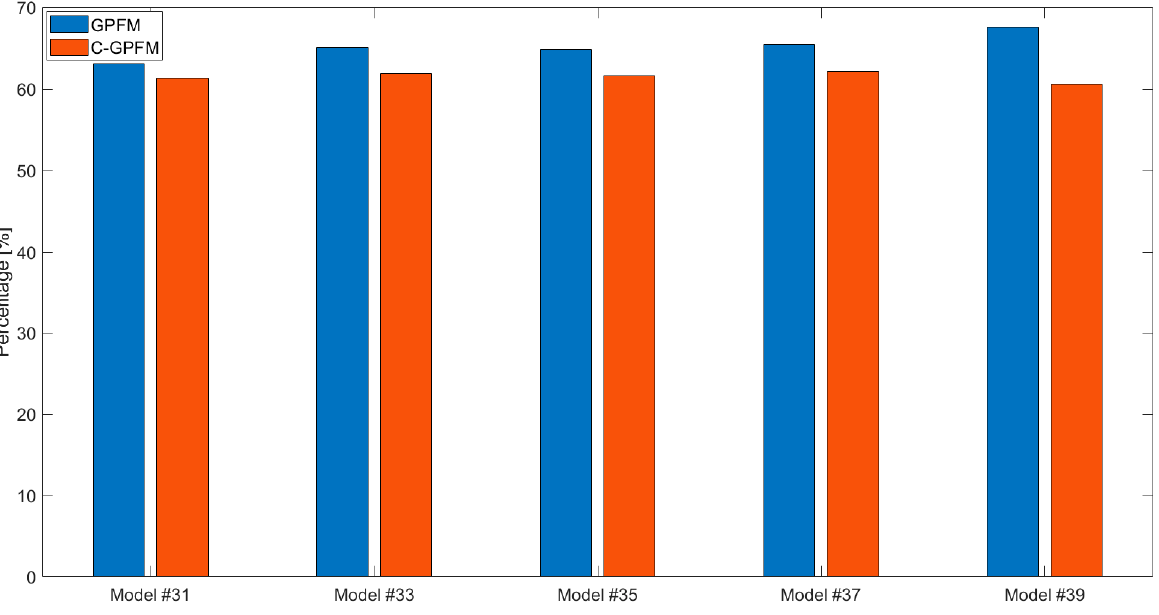
Figure 8. Percentage of the runs in which C-GPFM led to smaller average state errors than GPFM. Results for the models obtained on days #31, #33, #35, #37 and #39 for Case Study #1. The superiority of the C-GPFM over GPFM stems only from the dynamic selection of specific parameters according to their correlation with the available measurements. In or- der to further investigate the relation between the accuracy of parameter estimation and selection frequency (i.e., parameter influence), the relative absolute error of each parame- ter (averaged over time) was plotted after sorting the parameters according to the number of times they were selected for adjustment (Figure 9). In addition, the number of times the parameter was selected for adjustment by C-GPFM is presented on the top of the figure. The relative error obtained by GPFM is also shown for comparison. Overall, the parame- ters selected more frequently are estimated more accurately than the parameters selected less frequently, which validates the motivation for the proposed approach, namely that the more strongly a parameter is correlated with measurements, the more influential the parameter is, and the more its estimation can be improved. As shown previously, the su- periority of C-GPFM over GPFM in estimating most of the parameters is clear. Again, overall, the shape parameter is more accurate than the others using both methods, as the soil moisture is closer to the residual water content than to the saturated water content.